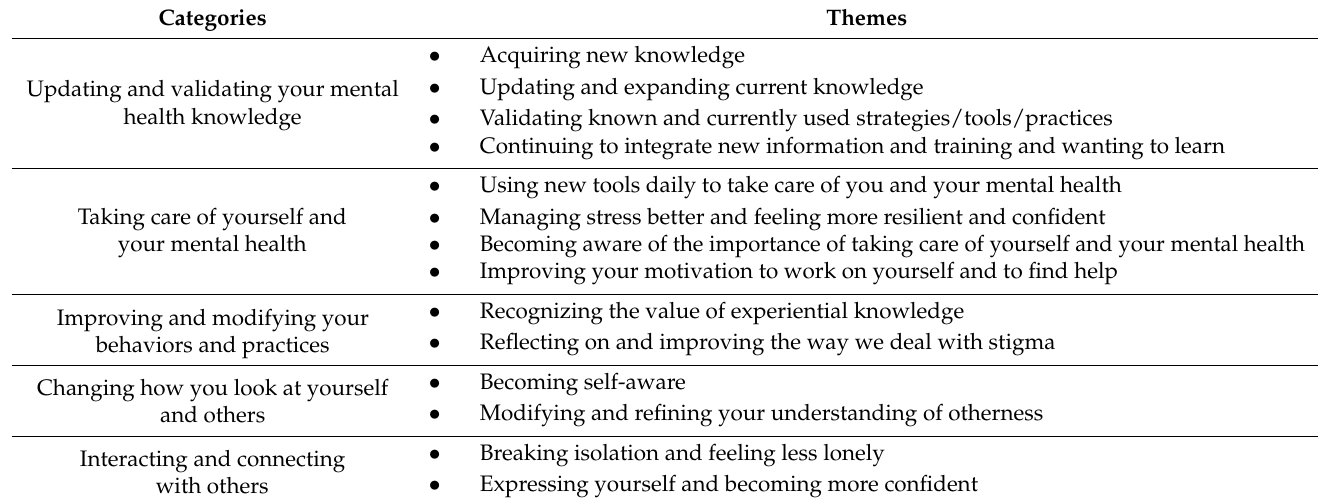
Table 3. Categories and themes to emerge from the thematic